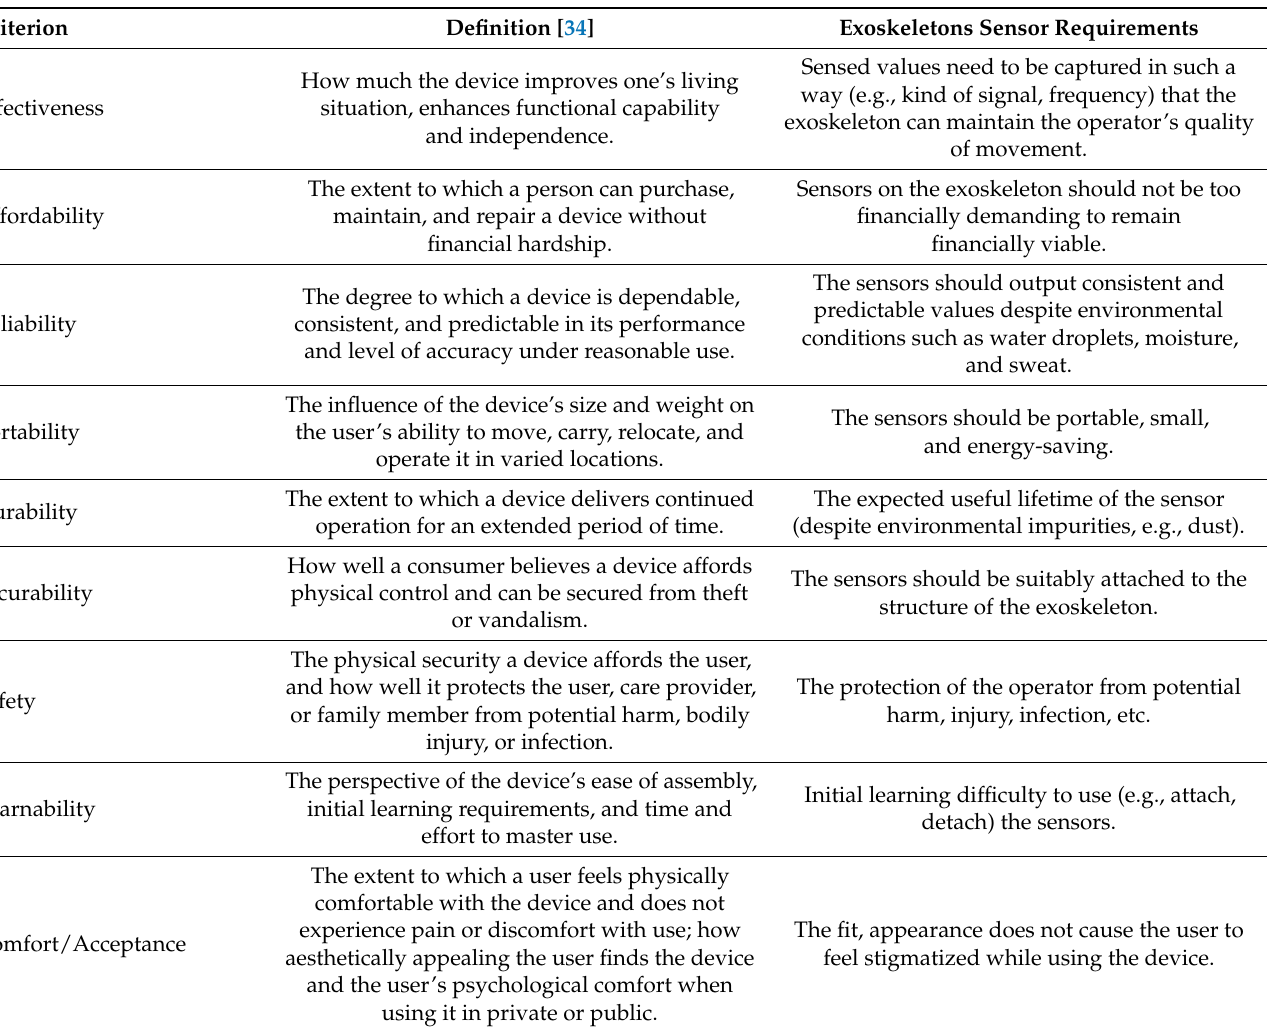
Table 1. Assistive devices requirements and how they relate to exoskeletons